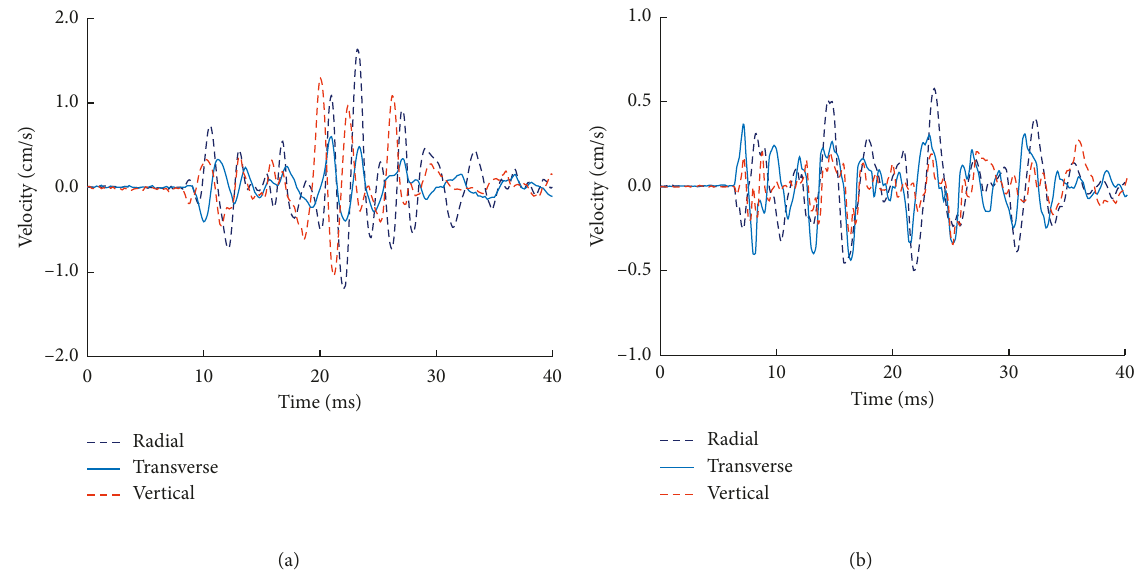
Figure 7: Velocities of simultaneous blasting and short-delay blasting. (a) Simultaneous blasting. (b) 8ms delayed